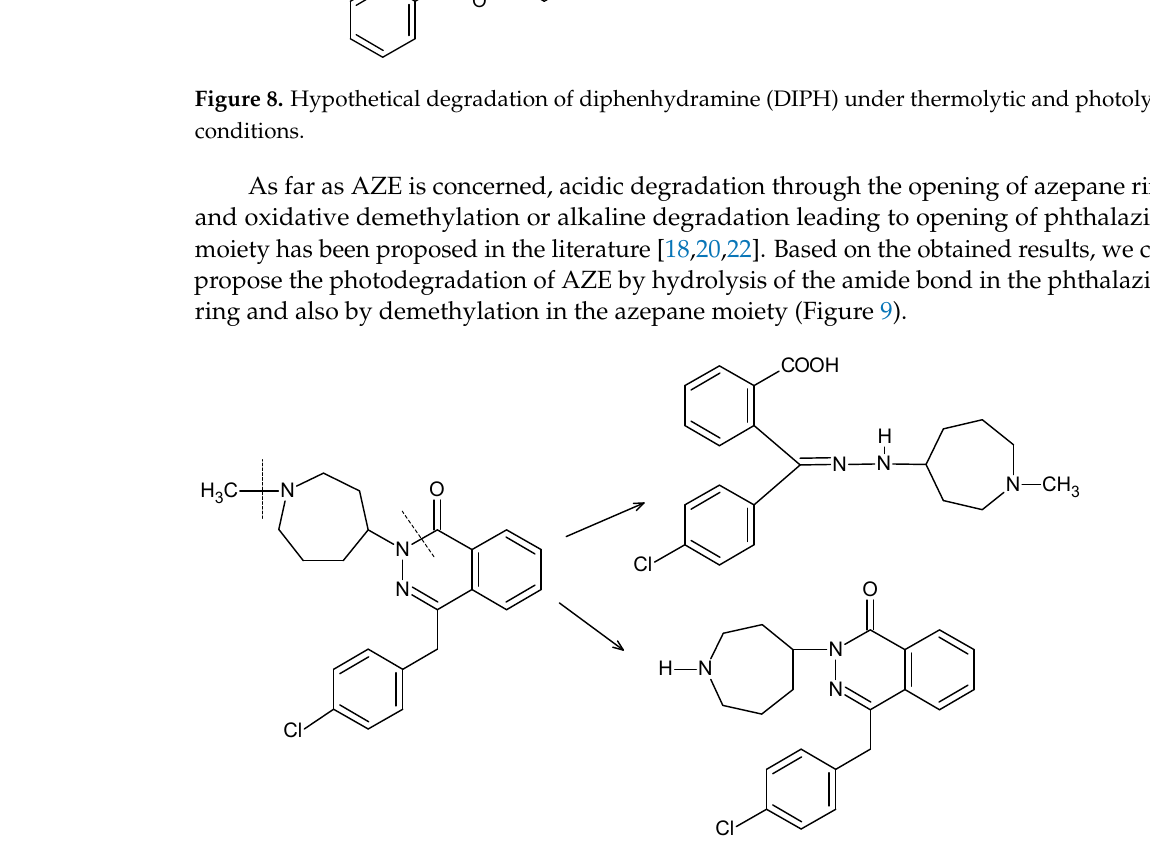
Figure 9. Hypothetical degradation of azelastine (AZE) under photolytic conditions.